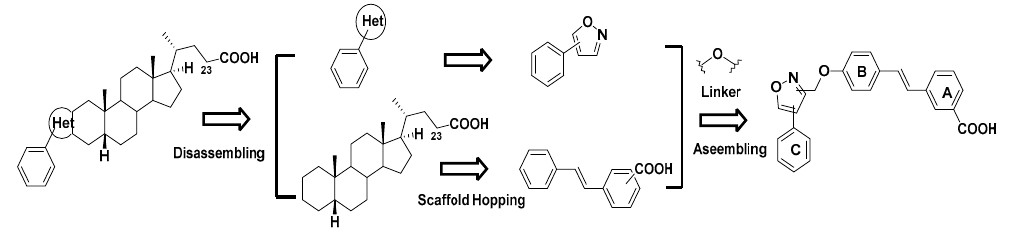
Figure 2. The design of the title compounds.